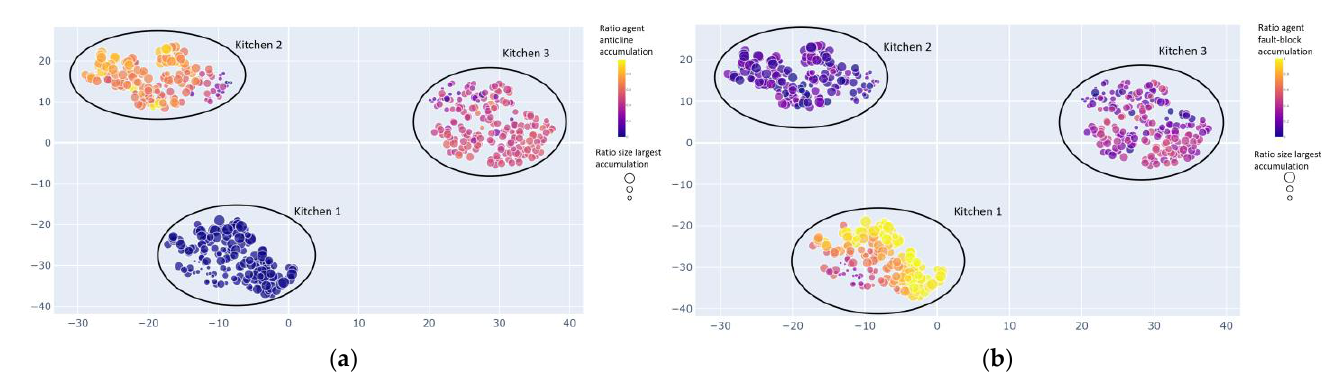
Figure 10. t-SNE visualisation showing the most impactful geological uncertainties and their correlation with simulation evaluation metrics, colour coded by ratio of agents in anticlinal accumulations ( a ) and fault block accumulations ( b ) and sized by the size of the largest accumulation.